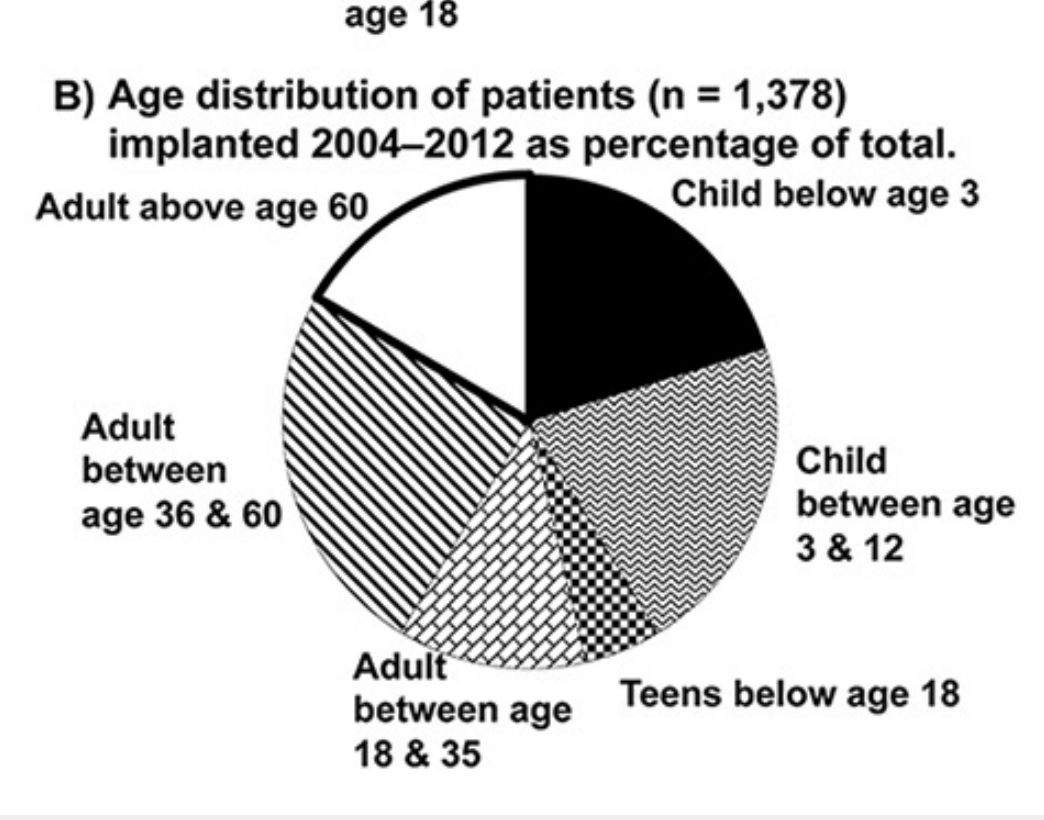
Figure 2 (A) Patients implanted in Switzerland 1999–2003 and (B) Patients implanted in Switzerland 2004–2012, divided into age groups